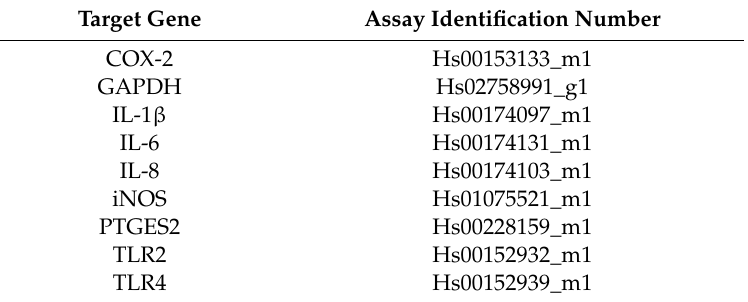
Table 3. TaqMan primers used for